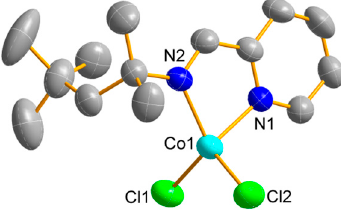
Figure 2. Molecular structure of complex 2b . (Thermal ellipsoids are shown at the 50% probability level.) Hydrogen atoms have been omitted for clarity.